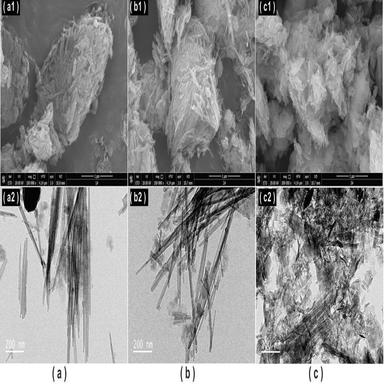
SEM and TEM characterization of AT(a), A-AT(b) and AT-NH2 (c).